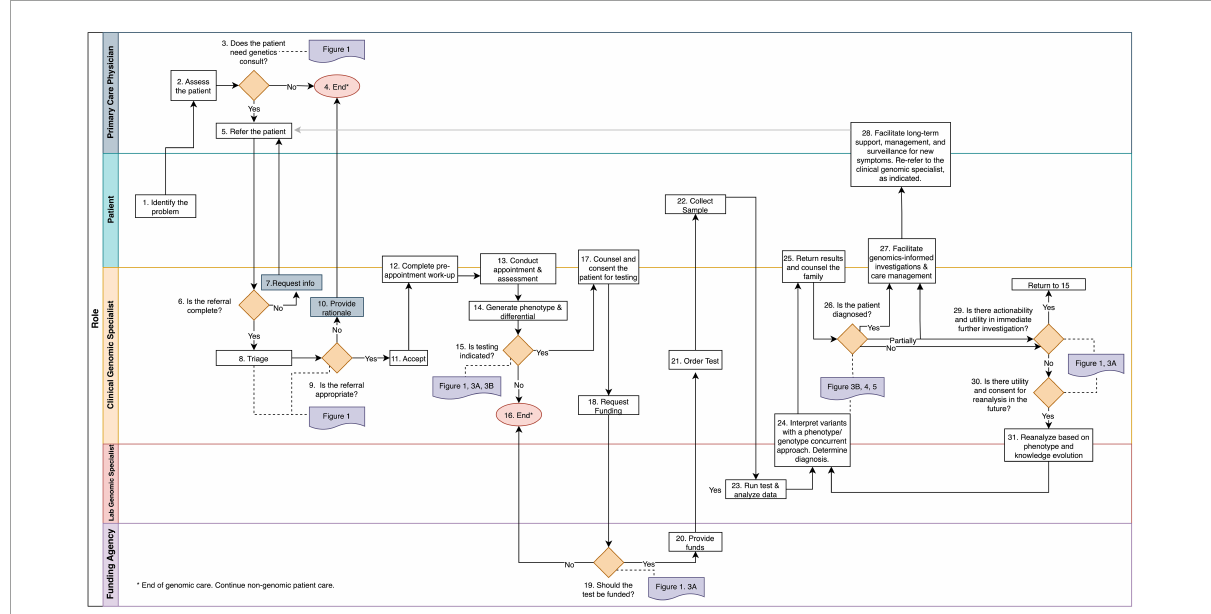
FIGURE2 The genomic medicine process map. This workflow illustrates genomic medicine practice, which differs from medical genetics in that molecular profiling is required for diagnosis. The process begins when a patient or the PCP identifies a health concern. Rectangles denote tasks and orange diamonds denote decision points. Swim lanes correspond to the player responsible for completion of the tasks. References to the frameworks and guidelines presented throughout the manuscript are in purple and are connect to the corresponding decision point with a dotted line. The tasks and decision points are numbered to reference text descriptions ( Supplementary material section 1 ); this numbering does not always reflect a linear sequence of steps due to decisional loops. Endpoints are denoted by pink